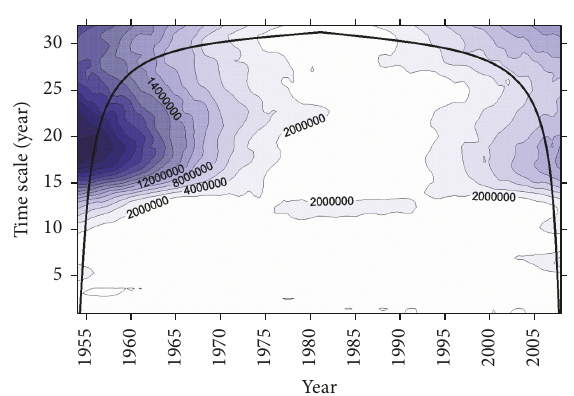
Figure 5: The contour of module of Morlet wavelet transform coefficient in YC